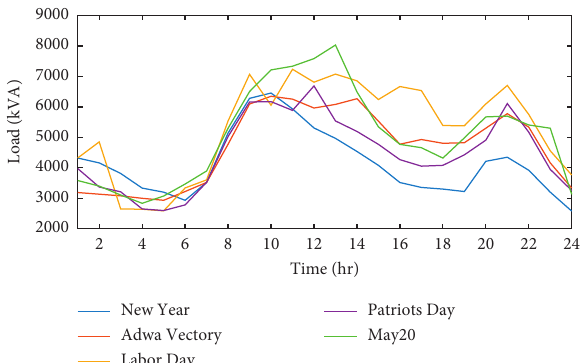
Figure 5: Hourly load profile of national holidays in 2018/19.